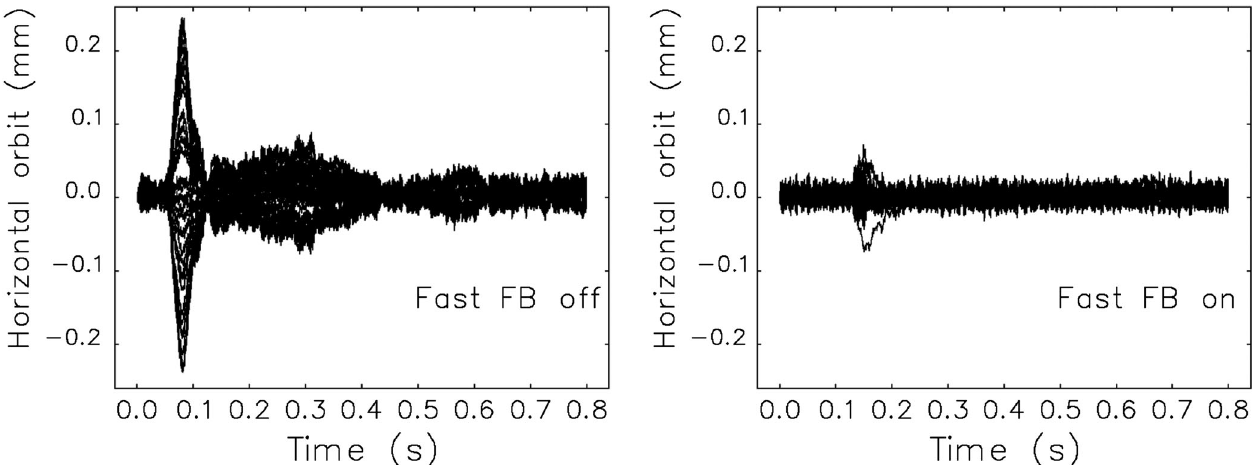
horizontal.FIG. 36. Effect of induced quench on the beam orbits at all the IDs. Left panel: Slow orbit correction only. Right panel: Fast orbit feedback (FB) turned